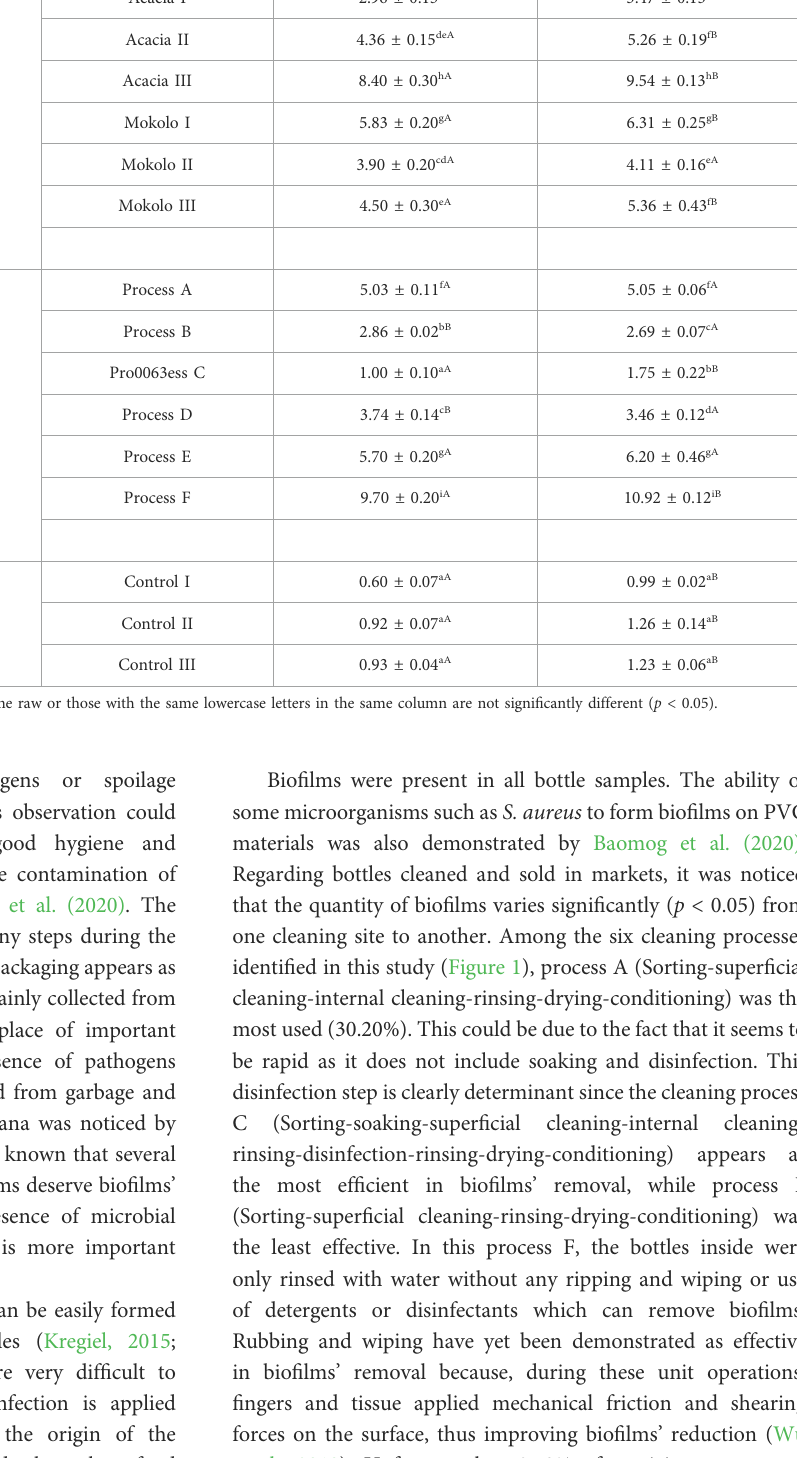
TABLE 4 Quantity of destained bio fi lms (in terms of absorbance at 595 nm) present in recovered plastic bottle samples collected in the city of Yaoundé.